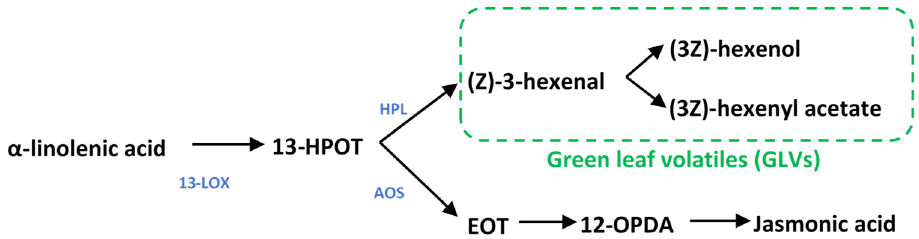
Figure 1. Metabolism of green leaf volatiles and jasmonates. 13-lipoxygenase converts a-linolenic acid into 13-HPOT, which can then be diverted into GLV production by HPL or jasmonate synthesis by AOS and downstream enzymes. 13-LOX13: 13-lipoxygenase; HPL: hydroperoxide lyase; AOS: allene oxide synthase; 13-HPOT: (9Z11E15Z13S)-hydroperoxyl-9,11,15-octadecantrienoic acid; EOT: 12,13(S)-epoxy-9(Z)-octadecatrienoic acid; 12-OPDA: cis-(+)-12-oxophytodienoic acid.